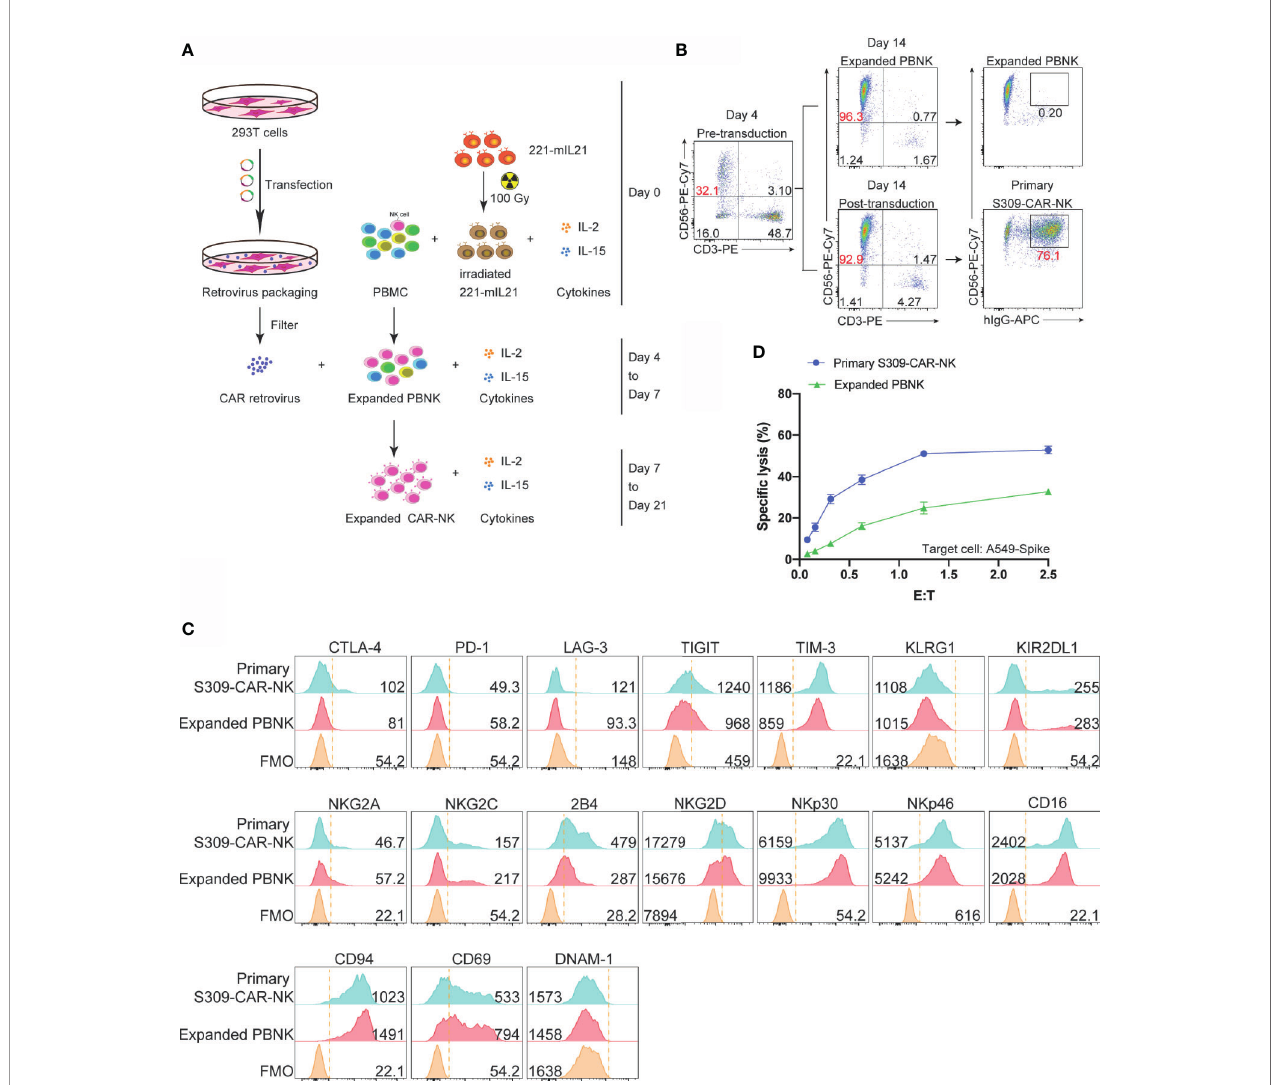
FIGURE 4 | Increased killing activity of expanded S309-CAR-NK primary against A549 Spike cell line. (A) Schematic representation of human S309-CAR-NK primary expansion system. Brie fl y, irradiated (100 Gy) 221-mIL21 feeder cells were cocultured with PBMC supplemented with IL-2 and IL-15 on Day 0. In parallel, 293T cells were transfected with the retrovirus packaging system to produce S309-CAR retrovirus that were then transduced into the expanded PBNK cells in the presence of IL-2 and IL-15. S309-CAR-NK primary cells were harvested on Day 7 and continued expansion for 21 days. (B) Representative dot plots of expanded primary NK cells and S309-CAR-NK primary . The purity of NK cells and the expression of CAR were monitored every 3-4 days. (C) Representative histogram of immunophenotyping of S309-CAR-NK primary cells using fl ow cytometry. Antibodies against various immunomodulatory receptors including CTLA-4, PD1, NKG2A, CD56, CD16, 2B4, NKG2C, NKG2D, NKp30, NKp46, DNAM-1, CD69, CD94, TIGIT, KLRG1, KIR2DL1, TIM-3, and LAG-3 were used to stain both primary NK cells and S309-CAR- NK primary . (D) Representative quantitative data of cytotoxic activity of S309-CAR-NK primary against A549-Spike. Brie fl y, expanded human S309-CAR-NK primary cells were blocked with anti-CD16 for 30 minutes and then anti-NKG2D for 30 minutes on ice. The target cells were labeled with Cr 51 for 2 hours prior to coculturing with S309-CAR-NK primary cells for an additional 4 hours. Representative data are shown in panel (D)